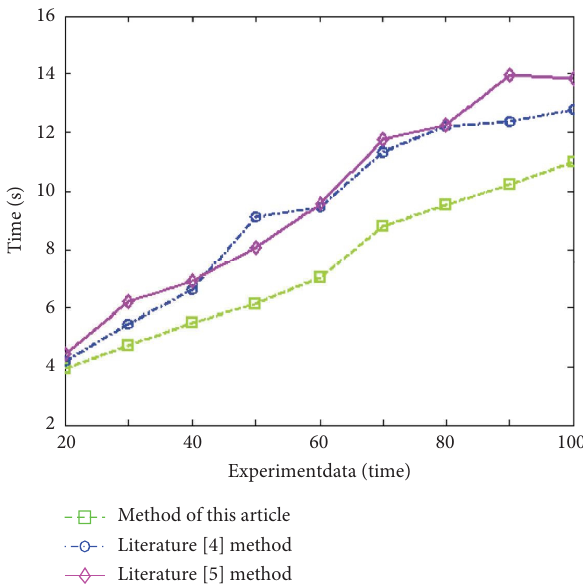
Figure 5: Comparison results of crawling time of three